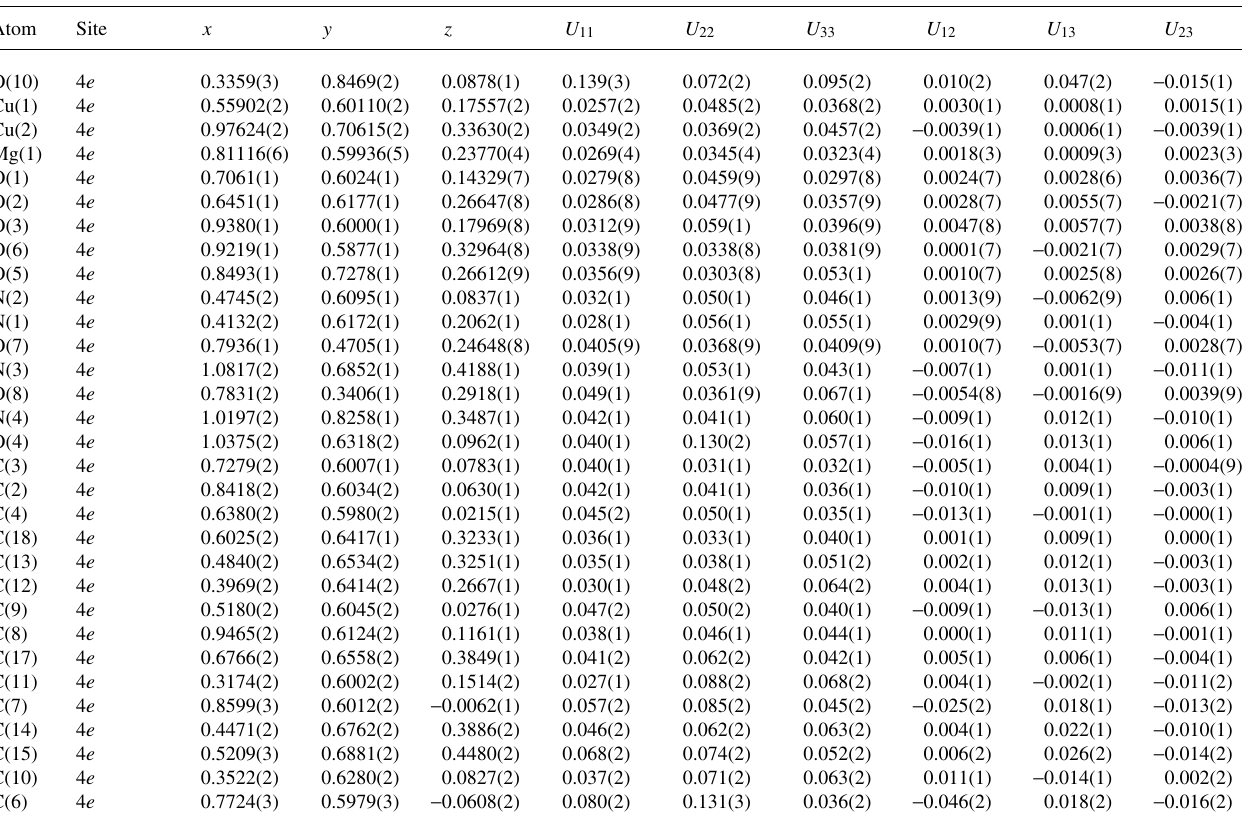
Table 3. Atomic coordinates and displacement parameters (in Å 2 ) .